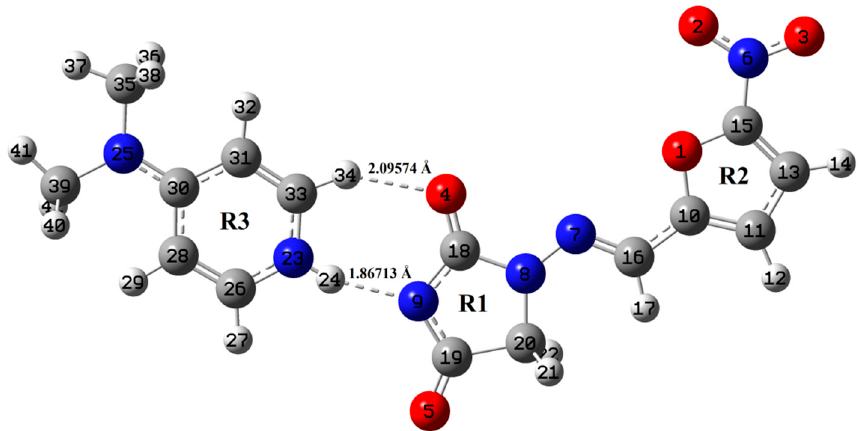
Figure 1. Optimized structure of NF-DMAP using B3LYP method.